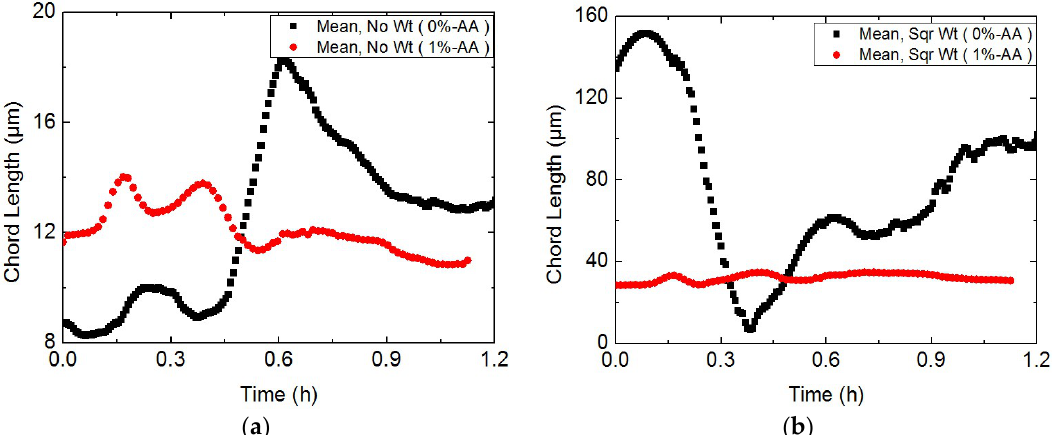
Figure 12. Influence of AA on mean chord length during the hydrate dissociation ( a , b ). ( a ) Influence of AA on mean chord length (5 MPa, 1.0 m/s flow rate, 25%water-cut); ( b ) Influence of AA on square-weighted chord length (5 MPa, 1.0 m/s flow rate, 25%water-cut).